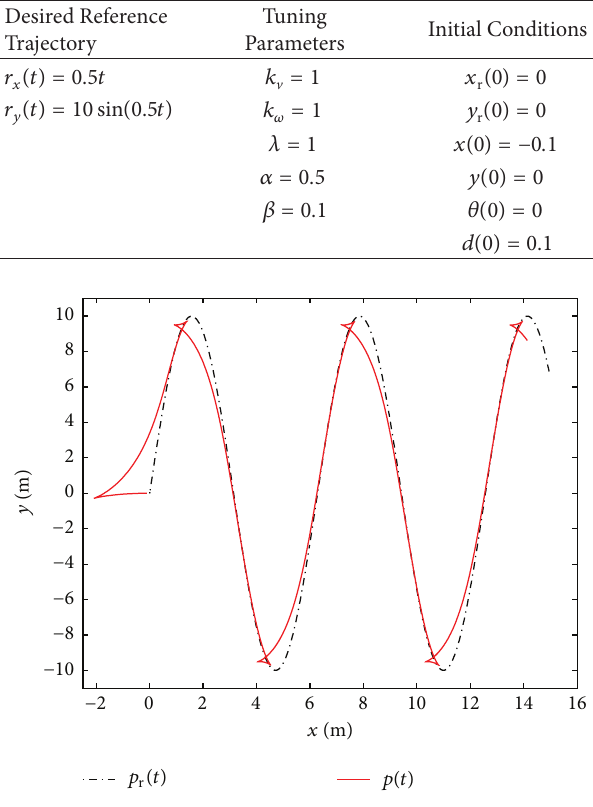
Figure 1: Sinusoidal trajectory without saturation.